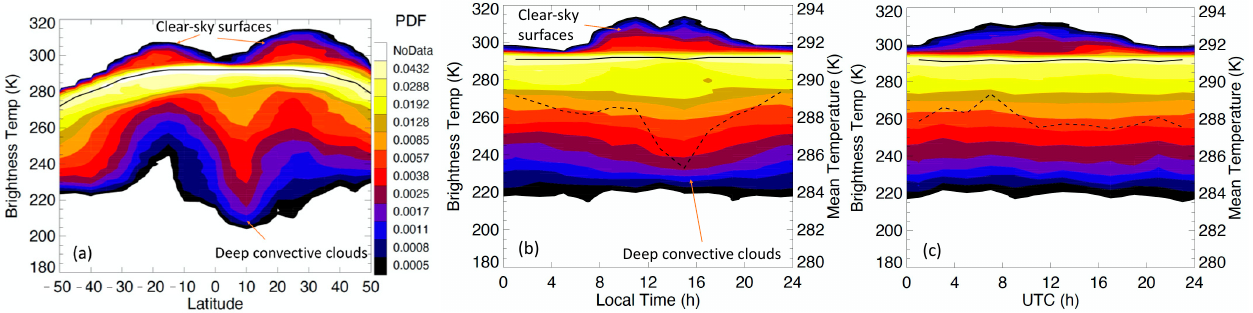
Figure 13. CTI band2 brightness temperature PDFs from July 2019 as a function of ( a ) latitude, ( b ) local time, and ( c ) universal time (UTC). The PDFs in ( b ) and ( c ) represent the global statistics from 50 ° S–50 ° N latitudes. Colored in a logarithmic scale, PDF was normalized at each bin such that its sum over all temperature bins was unity. The solid black lines in ( a ) and ( b ) indicate the temperature of PDF peaks, whereas the dashed lines in ( b ) and ( c ) denote the mean temperature from each local-time bin. Cloud contributions were approximately those values at temperatures that were ~10 K below the PDF peak (the solid black line in each panel).